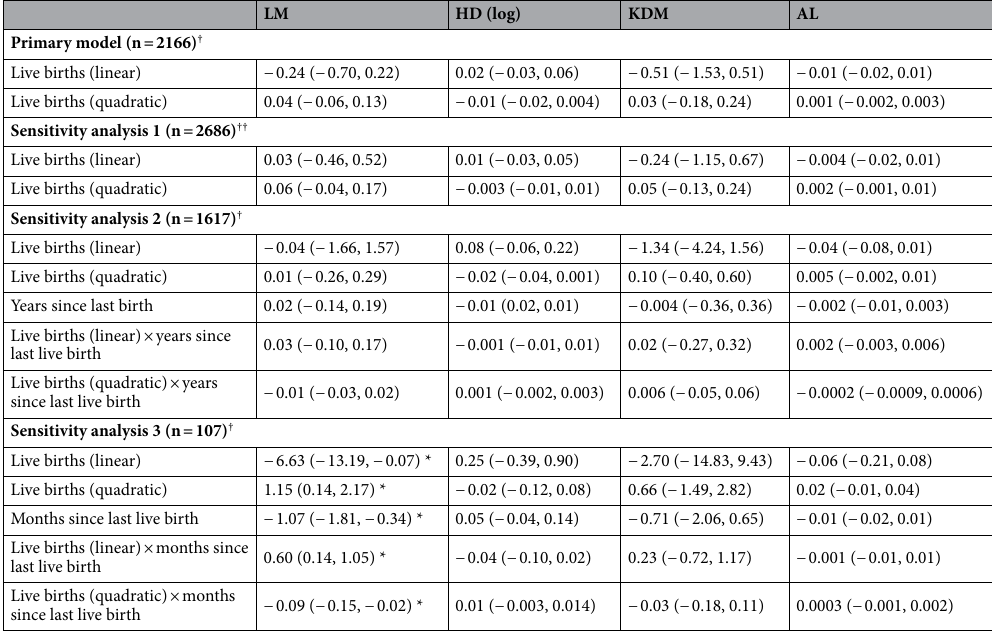
Table 2. Multiple linear regression examining the durable and transient effects of number of live births on biological age acceleration for pre-menopausal women only, National Health and Nutrition Examination Survey 1999–2010. Values represent coefficient estimates and 95% confidence intervals. † Models were adjusted for the following variables: chronological age, body mass index, federal income-to-poverty ratio, smoking, education, and self-identified race/ethnicity. †† Model was adjusted for chronological age only. * p < 0.05, ** p < 0.01, *** p < 0.001; values in bold represent effects significant after multiple comparison correction at α = (0.05/4) =